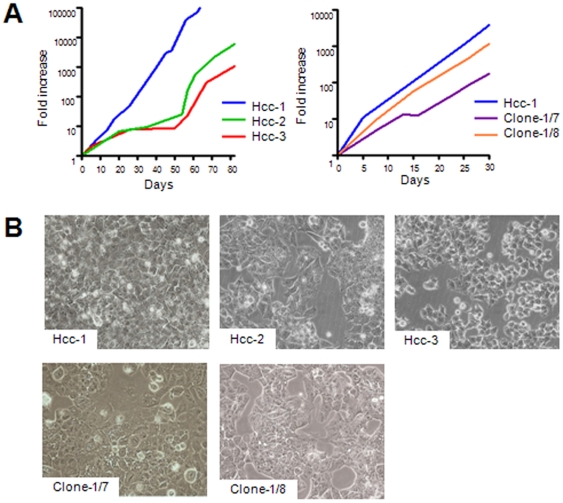
Different cell proliferation and morphology of the cell populations and clones generated from a single HCC specimen.A) Growth kinetic curves of the cell populations and clones. Hcc-1, hcc-2 and hcc-3 had doubling times of three, seven and six days respectively (left panel); hcc-1, clone-1/7 and clone-1/8 had doubling times of three, 4.7 and 3.6 days respectively (right panel). B) Representative phase-contrast images showing the morphology of the cell populations and clones; original magnification 20×.